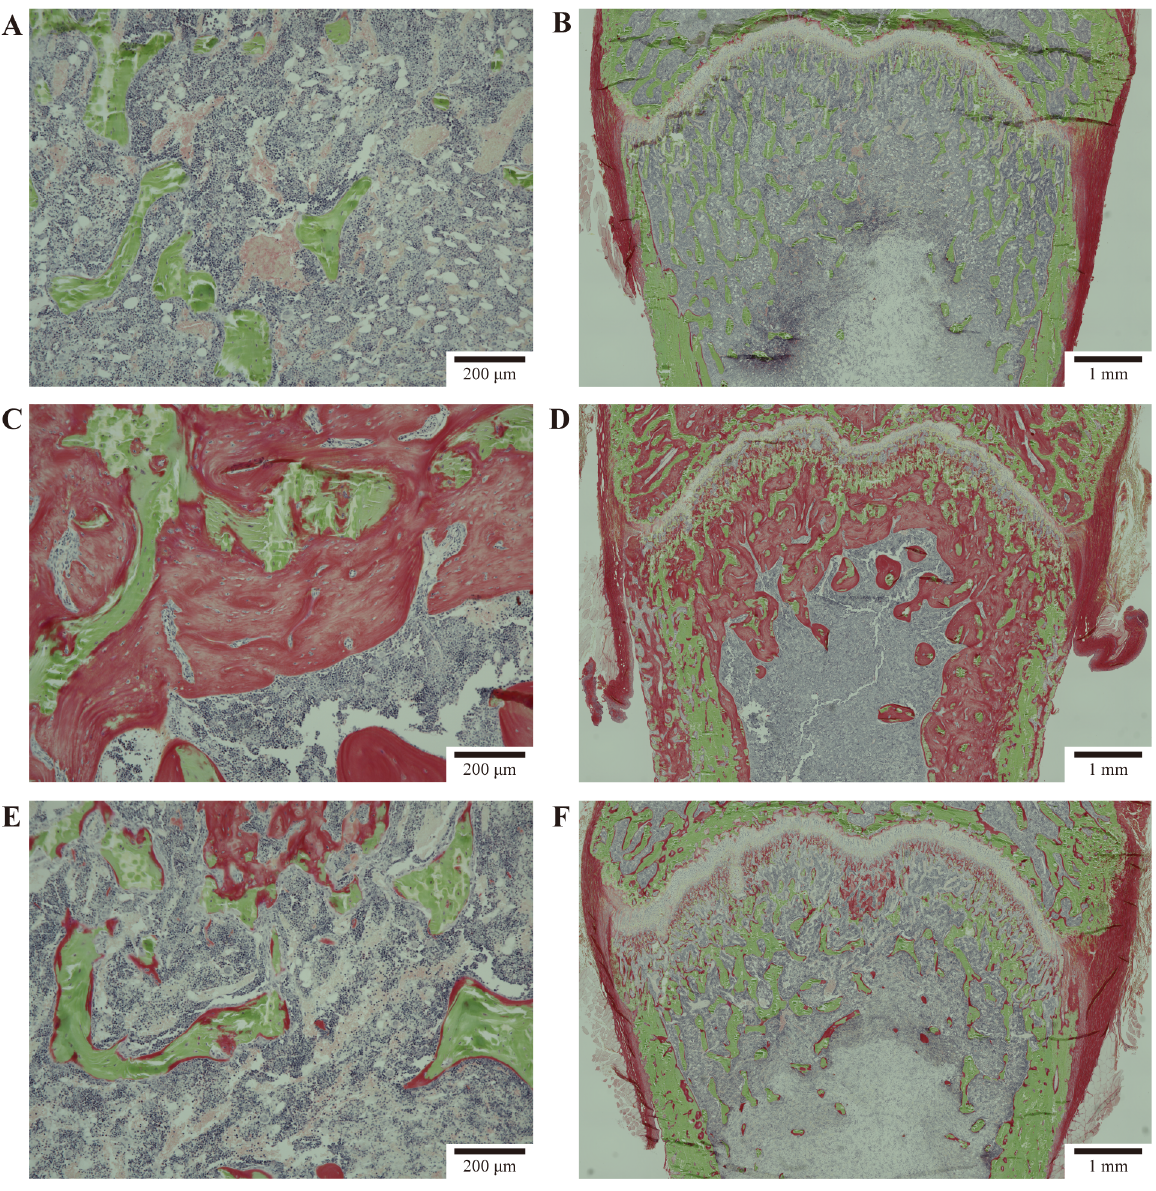
Fig 5. Representative images of the proximal femur of normal or CRF rats after four weeks of treatment with normal or 5% PA21 containing diet. The sections (6 μ m) were cut and stainedwith a Villanueva-Goldnerstain for bright-fieldmicroscopy. Representative images (low and high magnification) from some groupsare presented. (A) Normal group (low magnification), (B) normal group (high magnification), (C) control group (low magnification), (D) control group (high magnification), (E) 5% PA21 group (low magnification), and (F) 5% PA21 group (high magnification). These sections demonstrate mature bone (yellowishgreen), immature (red) and other